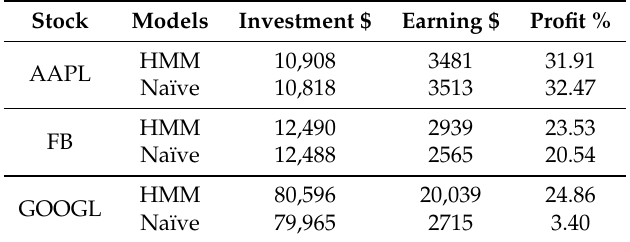
Table 3. Stock trading results from 15 August 2016 to 11 August